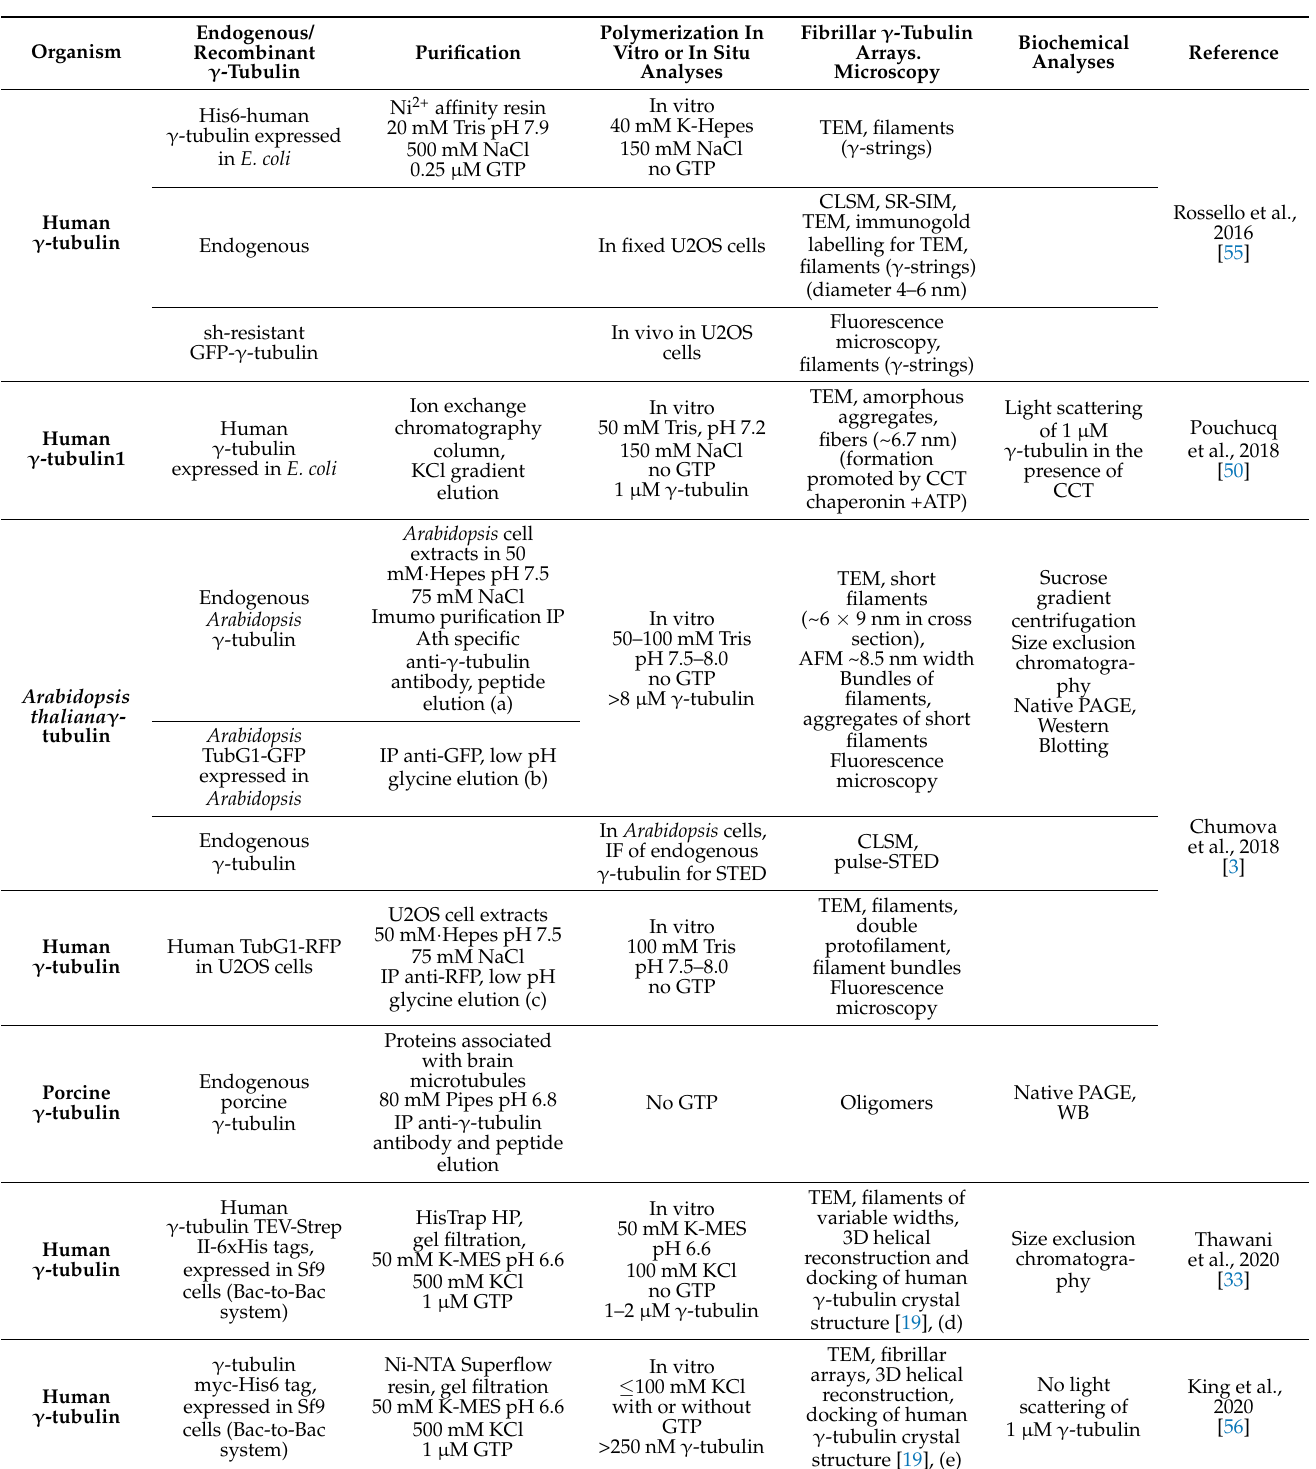
Table 1. γ -Tubulin fibrillar